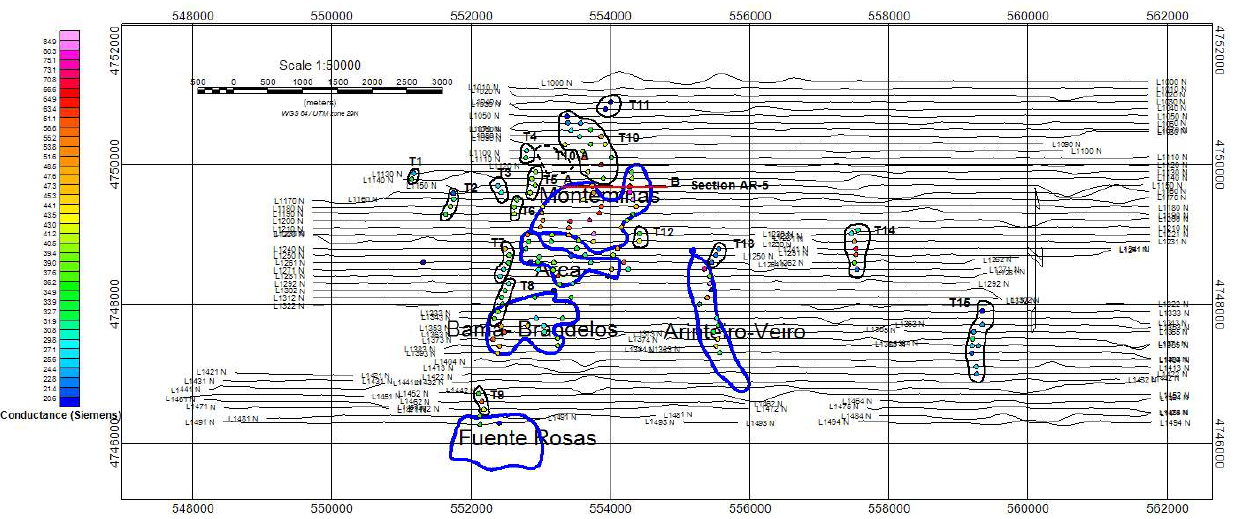
Figure 5. VTEM anomaly picks with >20 Siemens conductance with selected targets outside of known ore zone, labelled T1->T15. Black outlines are the 15 new anomalies detected. Blue lines are the existing ore blocks of the Touro VMS deposit.